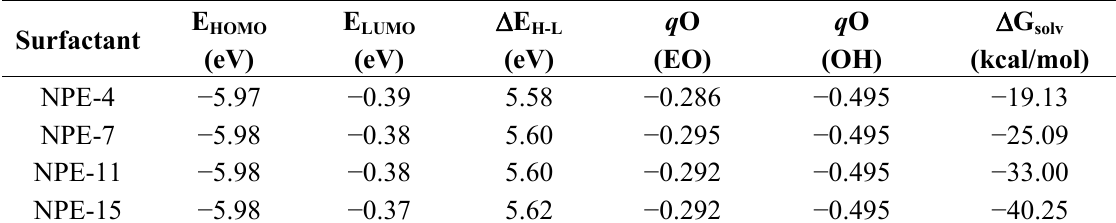
Table 1. Electronic properties, charge of O atoms and solvation Gibbs energy in water of